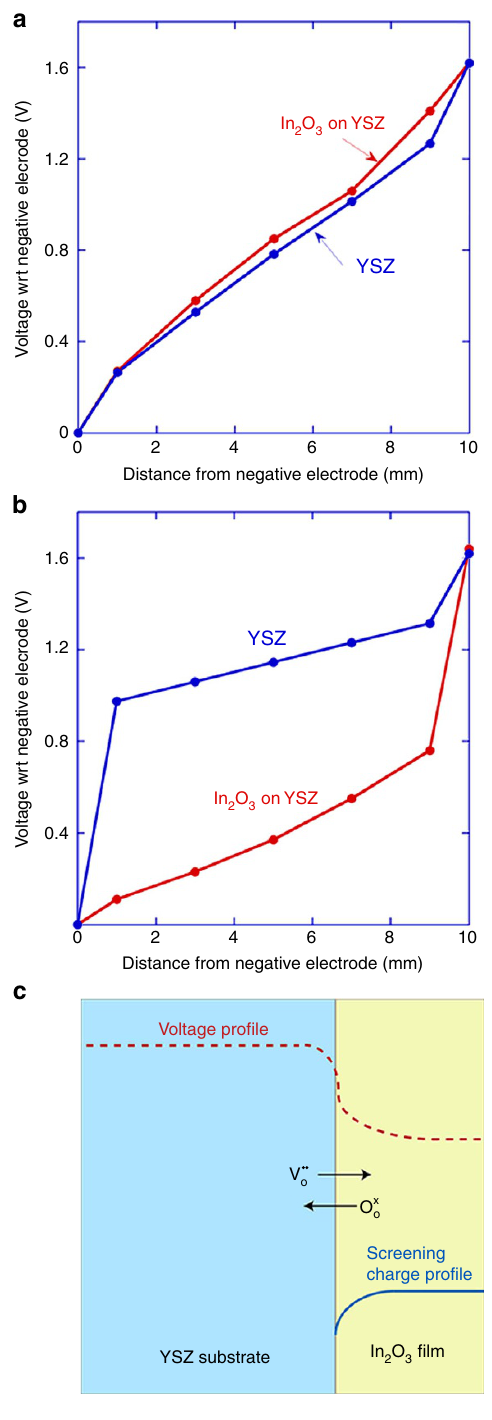
Figure 3 | Voltage profiles. ( a ) Initial voltage profile across a bare YSZ substrate compared with the profile across a 51nm thick In 2 O 3 -on-YSZ sample when a 1.6volt battery is connected to electrodes 1 and 7 at 330 (cid:2) C (electrode configuration shown in Fig. 1). Minimal contact resistances are present initially. ( b ) The voltage profiles after 5min (at steady state) for the has developed at the negative electrode (where oxygen entry occurs). A smaller contact resistance appears at the positive electrode (oxygen